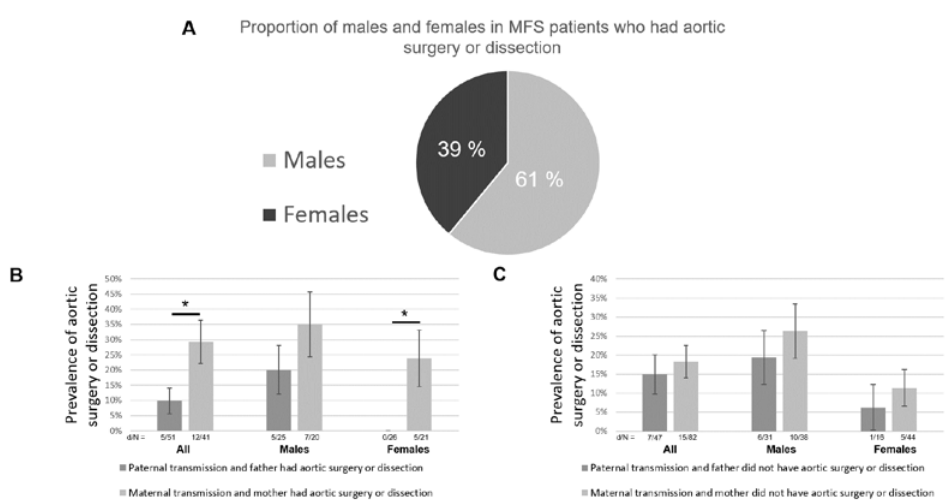
Figure 4. The Carter effect on the cardiovascular phenotype of MFS. ( A ) 61% of patients that had aortic surgery or dissection were males ( p = 4.9 × 10 − 5 ). ( B ) Among MFS patients whose transmitting parent had aortic surgery or dissection, the prevalence of aortic surgery or dissection was significantly higher in the case of maternal transmission ( p = 0.018). Standard deviations (SDs) are represented by error bars. d / N: number of patients with aortic surgery or dissection / sample size. ( C ) Among MFS patients whose transmitting parent did not have aortic surgery or dissection, the prevalence of aortic surgery or dissection was slightly higher in the case of maternal transmission (non-significant). SDs are represented by error bars. d / N: number of patients with aortic surgery or dissection / sample size. *: p < 0.05.